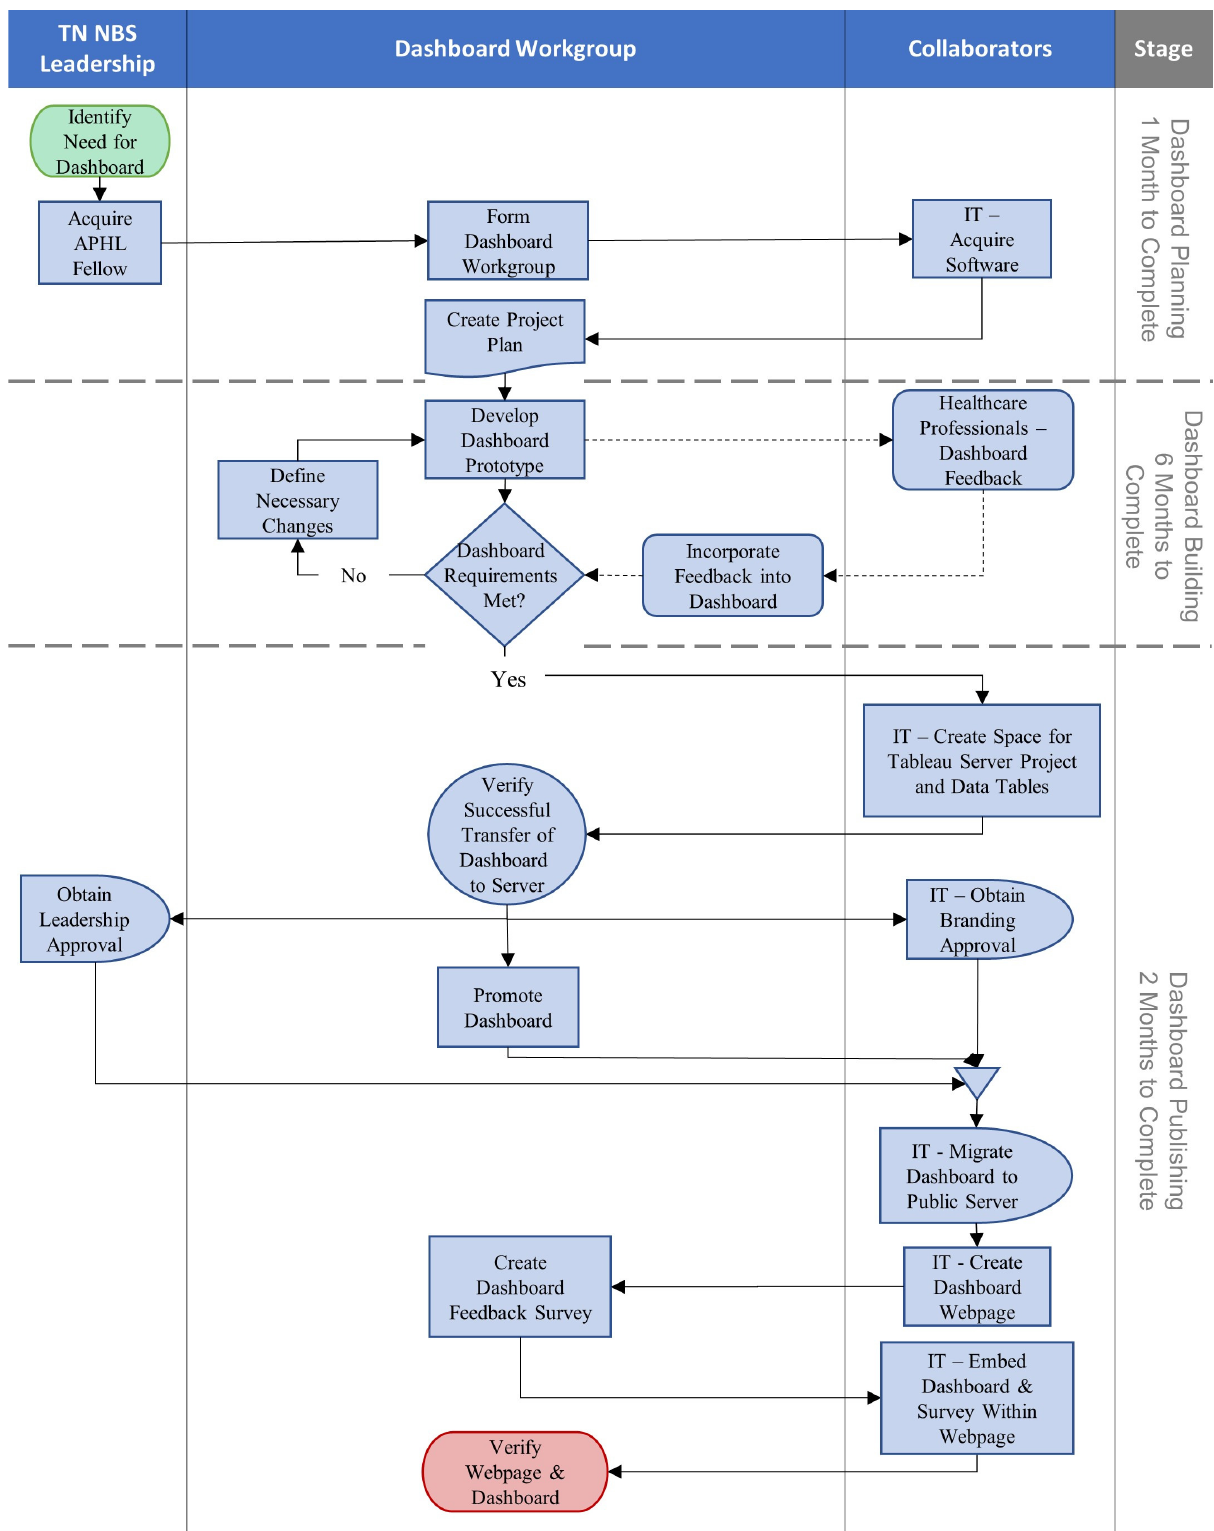
Figure 1. Tennessee (TN), Newborn Screening (NBS), Association of Public Health Laboratories (APHL), Information Technology (IT). A process map documenting the major steps taken during the dashboard’s development. Steps are grouped based on the dashboard development timeline and who was responsible for step